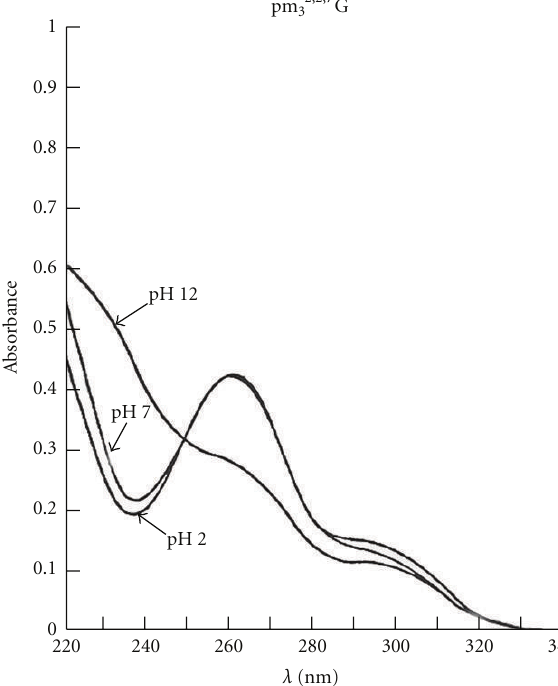
Figure 8: The UV spectra of pm 32,2,7 G [12]. The ultraviolet absorp- tion spectra were recorded on a Cary 14 spectrometer immediately after addition of compound to solutions at pH 2, 7, and